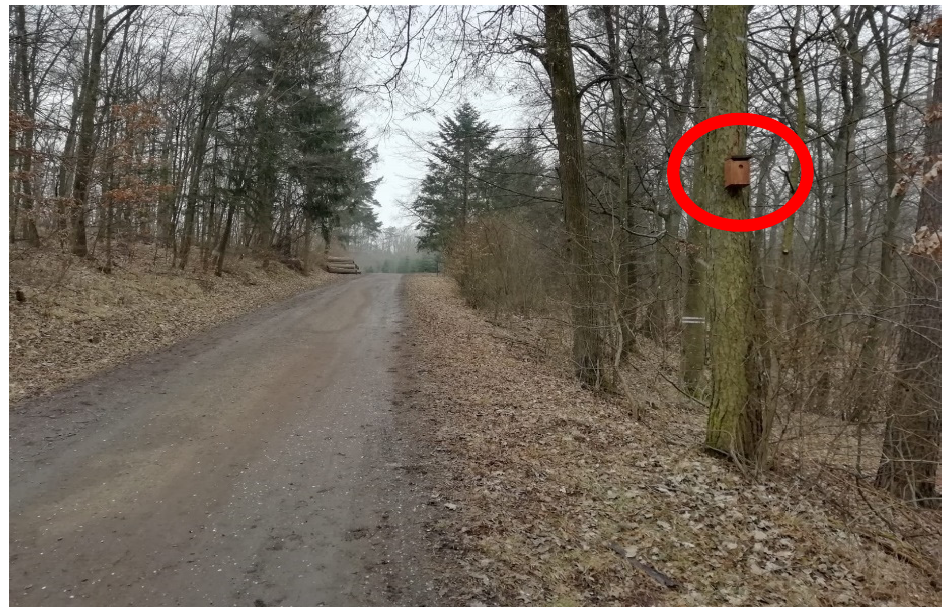
Figure 3. The TRAFx infrared trail counter counts people—walkers, hikers, joggers, inline skaters, horseback riders, and cyclists. Installed counter in the form of the wooden nest (in red circle) in the year 2021 (photo by: Jitka Fialová, 15 March 2021).